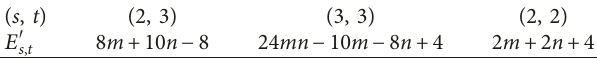
5 C 7 (2, 4) and (b) HC 5 C 7 (2, 4). E s,t . 5 C 7 ( m , n ) into